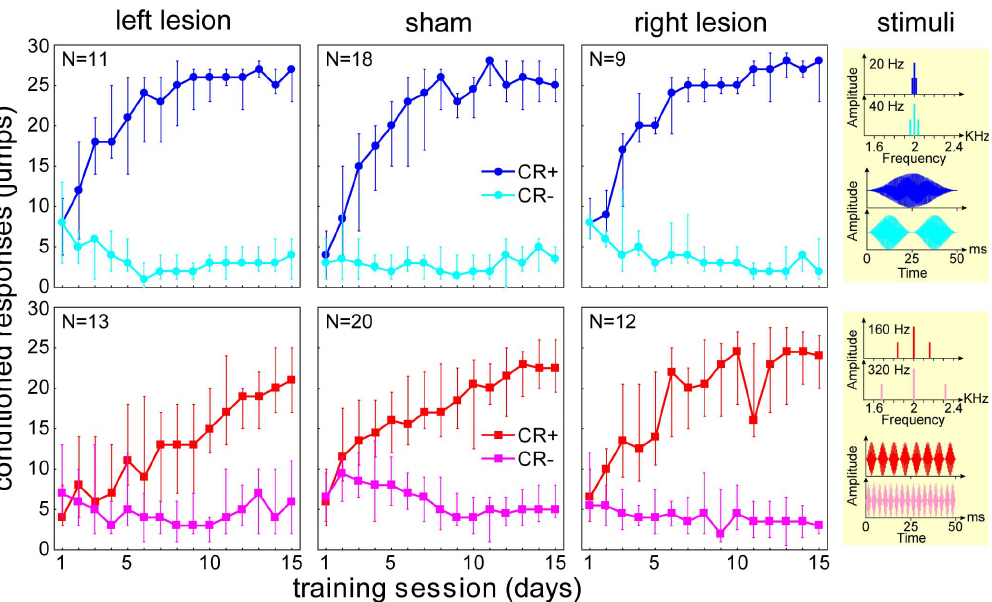
Figure 2. Discrimination learning curves of left and right AC lesion and control groups. Large panels show medians and quartiles of conditioned response counts as a function of daily training sessions. Each session consisted of 60 trials with 30 pseudo-randomized presentations of each stimulus (30 CR + equal 100% correct responses, 30 CR- equal 100% false alarms). Panels in top row (blue data points) give learning curves of animals that were trained to discriminate periodicities of 20 Hz (= CS + ) vs. 40 Hz (CS–), panels in bottom row (red data points) those of animals that were trained to discriminate periodicities of 160 Hz (= CS + ) vs. 320 Hz (CS–). Yellow panels on the right side show spectrum and waveform of the training stimuli.